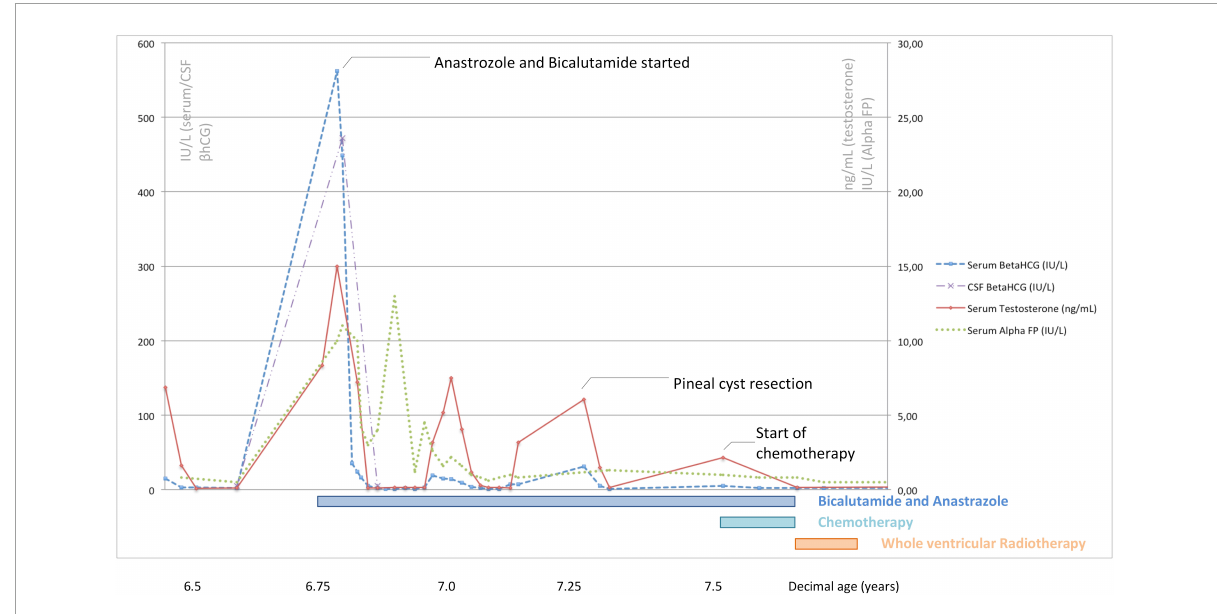
FIGURE3 Serum/cerebrospinal β -hCG, serum alpha-fetoprotein, and serum testosterone levels recorded at different time points in relation to the treatments undertaken in the patient